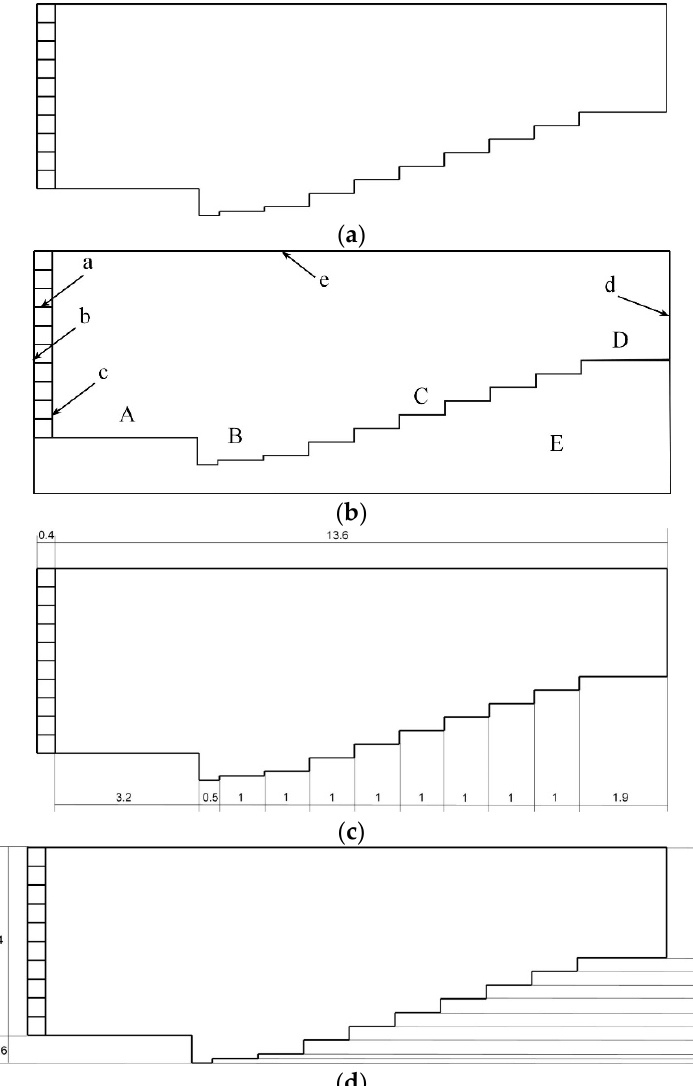
Figure 2. Scheme of a section of the auditorium and the respective dimensions. ( a ) Two-dimensional vertical section, ( b ) identification of the bodies and areas, ( c ) horizontal dimensions, and ( d ) vertical dimensions.